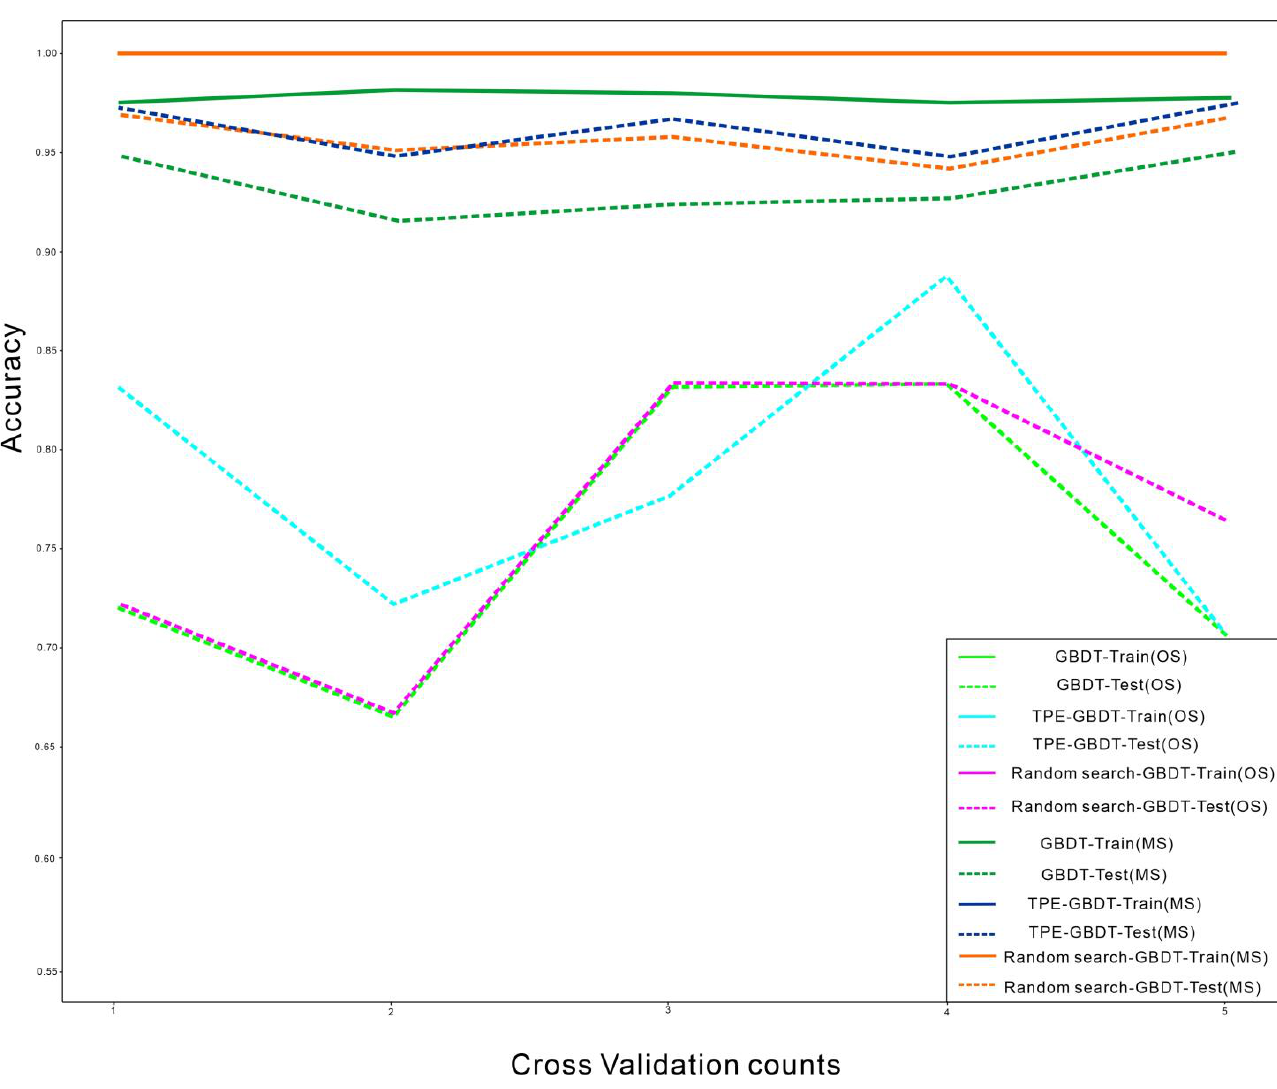
Figure 8. The Accuracy of five-fold cross-validation based on the GBDT model.